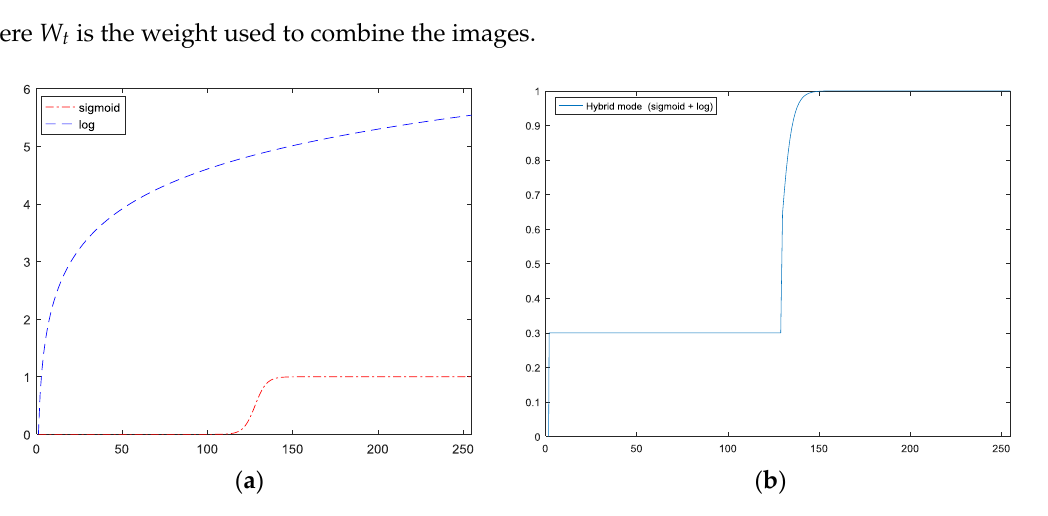
Figure 10. Comparison between different MSR results ( a ) Original, ( b ) Log-based MSR, ( c ) Sigmoid- based MSR. 3.2. Convolutional Neural Network (CNN) Features A convolutional neural network is composed of one or more convolution layers plus fully connected layers (corresponding to classical neural networks), but also include weighting and pooling layers. This structure allows convolutional neural network to make use of: (1) nonlinear units